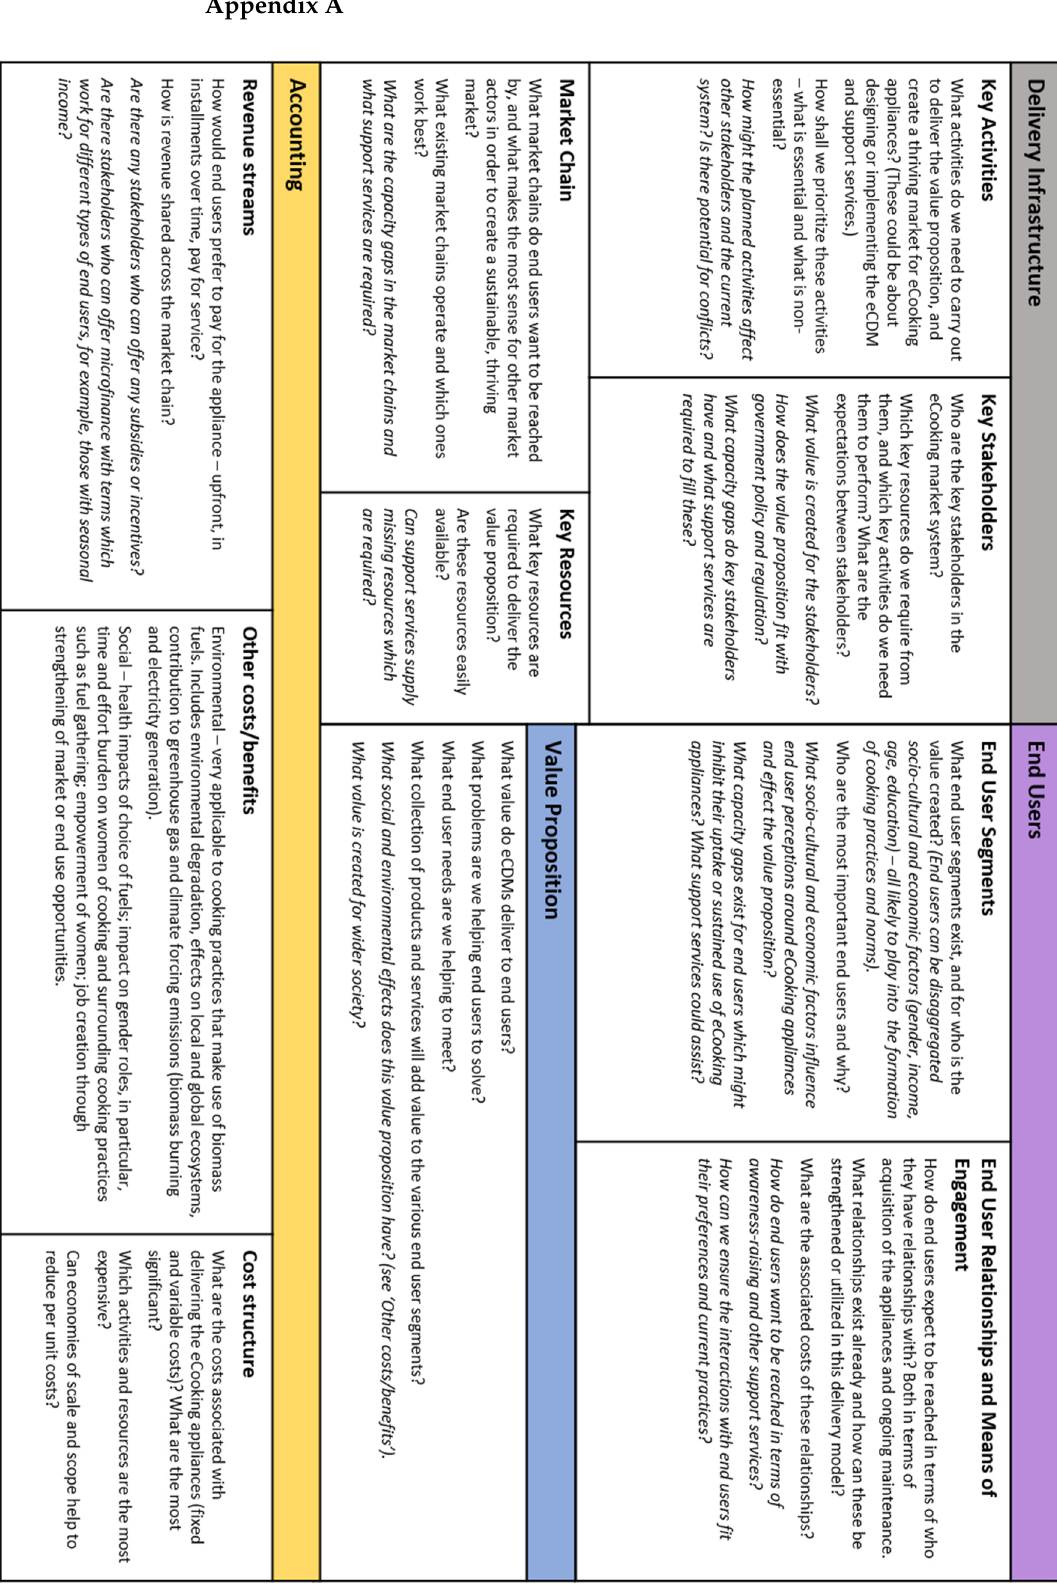
Figure A1. eCooking Delivery Model Canvas (Author’s own adapted from [22,24]).